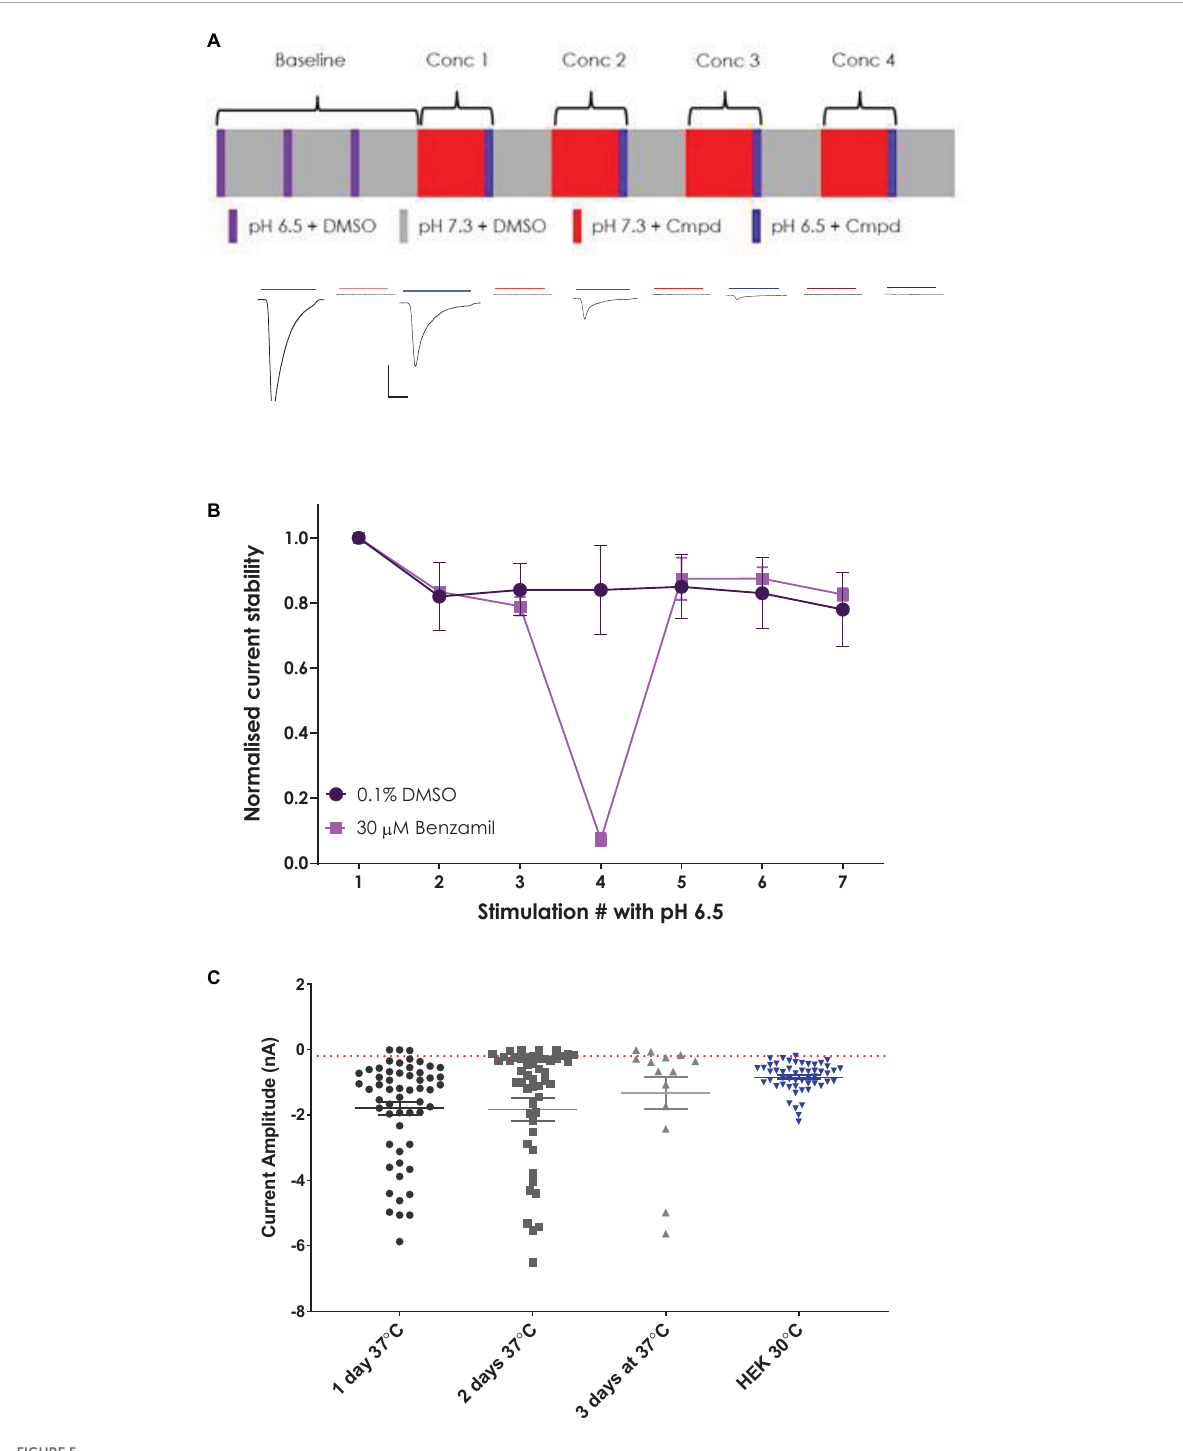
FIGURE5 Establishing a stable and robust CHO hASIC1a assay format on QPatch 48. (A) Schematic of liquid applications and pre-incubations for a cumulative xC 50 assay format (upper panel) and exemplar current traces with color-coded application bars (lower panel). Scale bar is 500 pA and 1 s. Minimum and maximum period between applications was 2–3 min. (B) Normalized current amplitude during repeated pH 6.5 stimulations in 0.1% DMSO vehicle (circles) or interspersed with a 30 µ M Benzamil pre-incubation (squares). Mean ± S.D from n = 7 and 2 cells, respectively. (C) Comparison of ASIC1a current expression in stable CHO and parental HEK cell lines. CHO cells grown at 37 ◦ C for 1–3 days, and HEK cells grown at 30 ◦ C. Mean ± S.E.M whole-cell current values shown by whisker graph. Red line is minimum QC current (–200